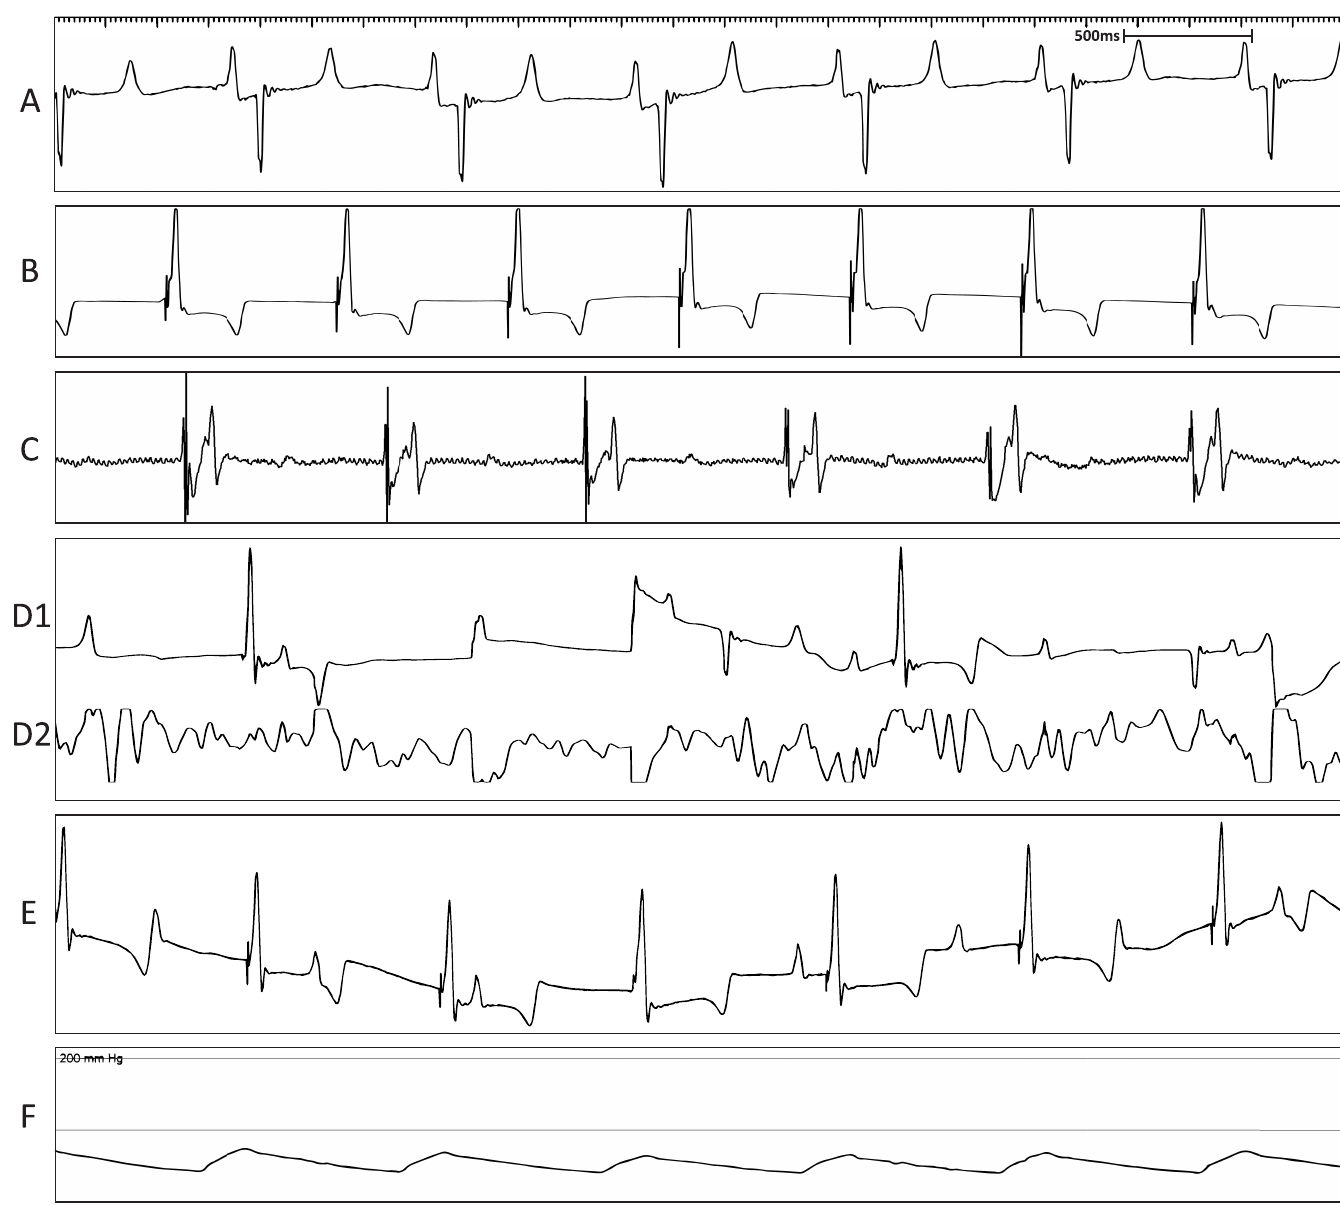
Fig 5. Representative surface ECG recordings during the ablation procedure confirming AVB model creation. (A) Surface ECG depicting normal sinus rhythm under anaesthesia. (B) Surface ECG depicting pacing rhythm during pacemaker diagnostics. (C) Bipolar electrogram from the ablation catheter proximal pair showing His electrogram before ablation. (D1) Surface ECG during ablation. (D2) Bipolar electrogram from the ablation catheter proximal pair during the ablation. (E) Surface ECG showing AVB evident by AV dissociation. (F) Mean arterial blood pressure trace indicating maintenance of blood pressure throughout the procedure.